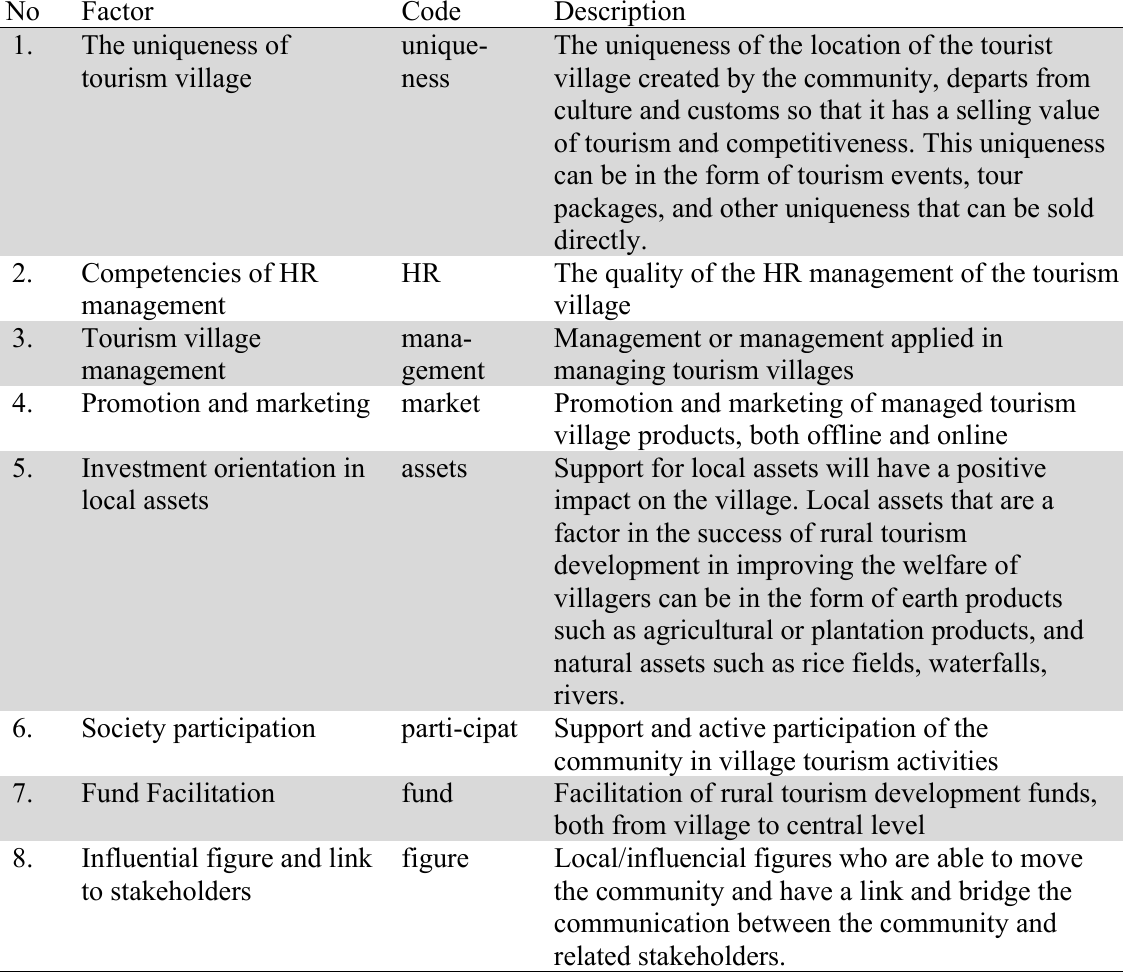
figure Local/influencial figures who are able to move the community and have a link and bridge the communication between the community and related